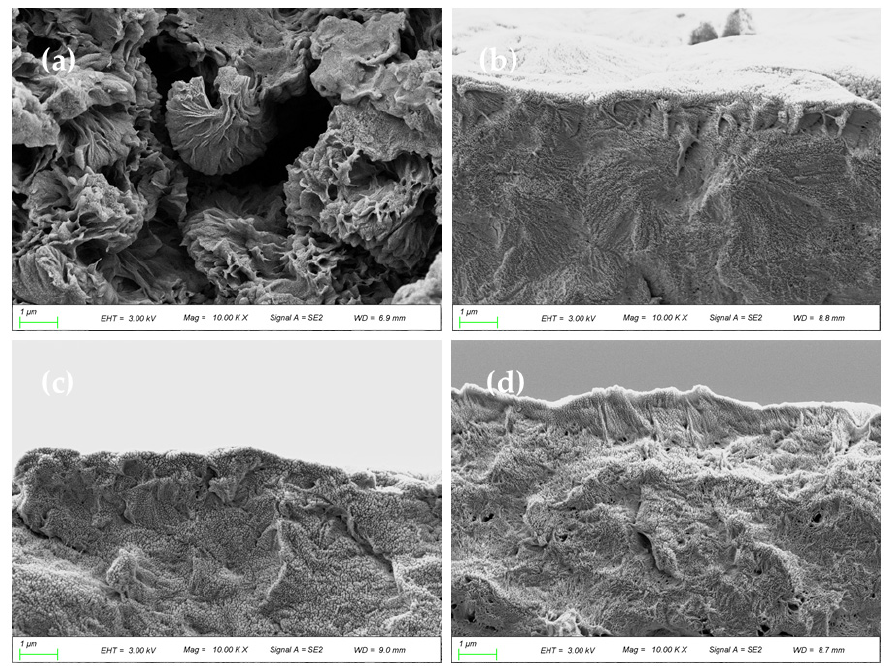
Figure 10. SEM images of cross-section of PA66 and PA66/GO membranes, ( a ) P0, ( b ) P1, ( c ) P2 and ( d ) P3.